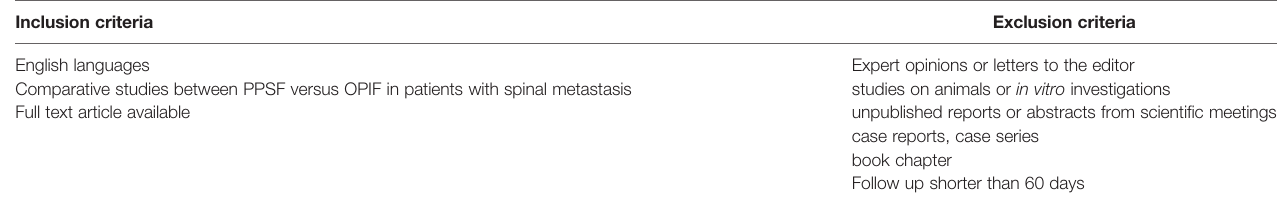
TABLE 1 | Inclusion and exclusion